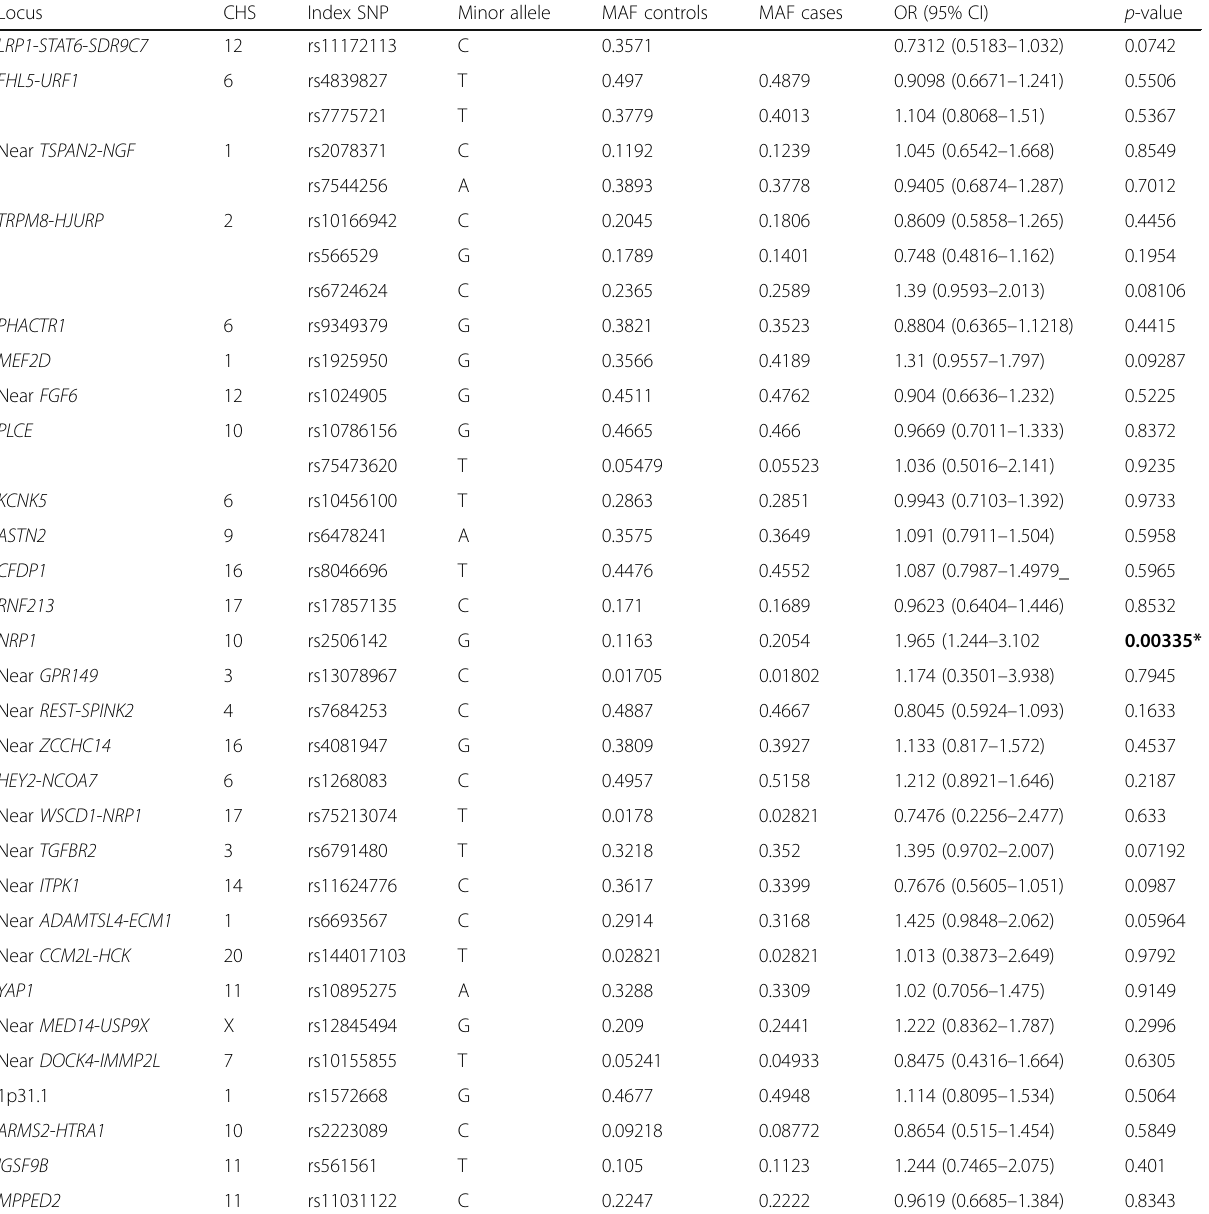
Table 1 Summary of the results obtained for the 34 SNPs from Gormley et al. genotyped in the menstrual migraine population